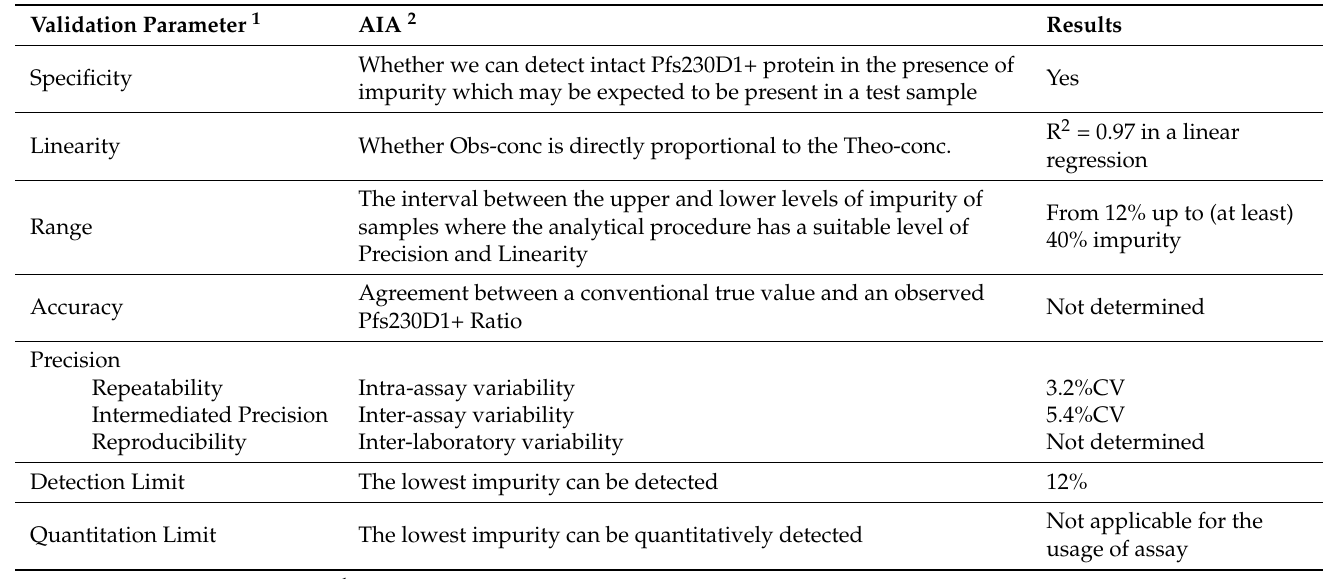
Table 1. Assay characteristics.